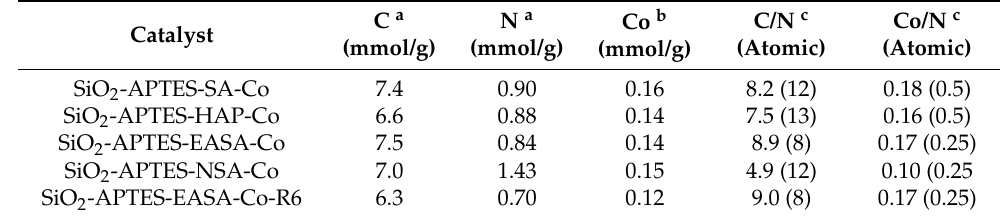
Table 1. Content of C, N and Co element in the fresh and the spent SiO 2 -APTES-EASA-Co catalysts.